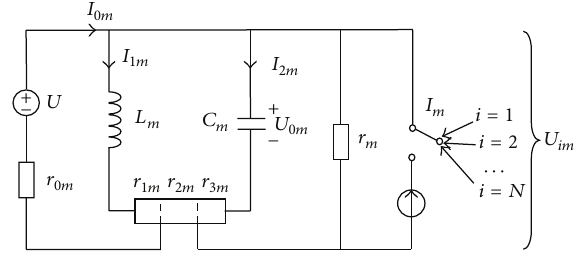
Figure 1: Physical model of the M th neuron with coupling to other